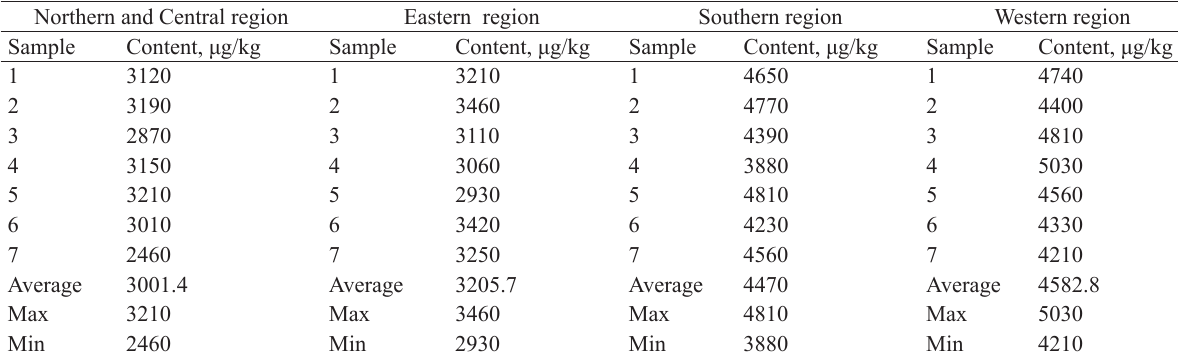
Table 4 Zinc contents in raw milk samples Northern and Central region